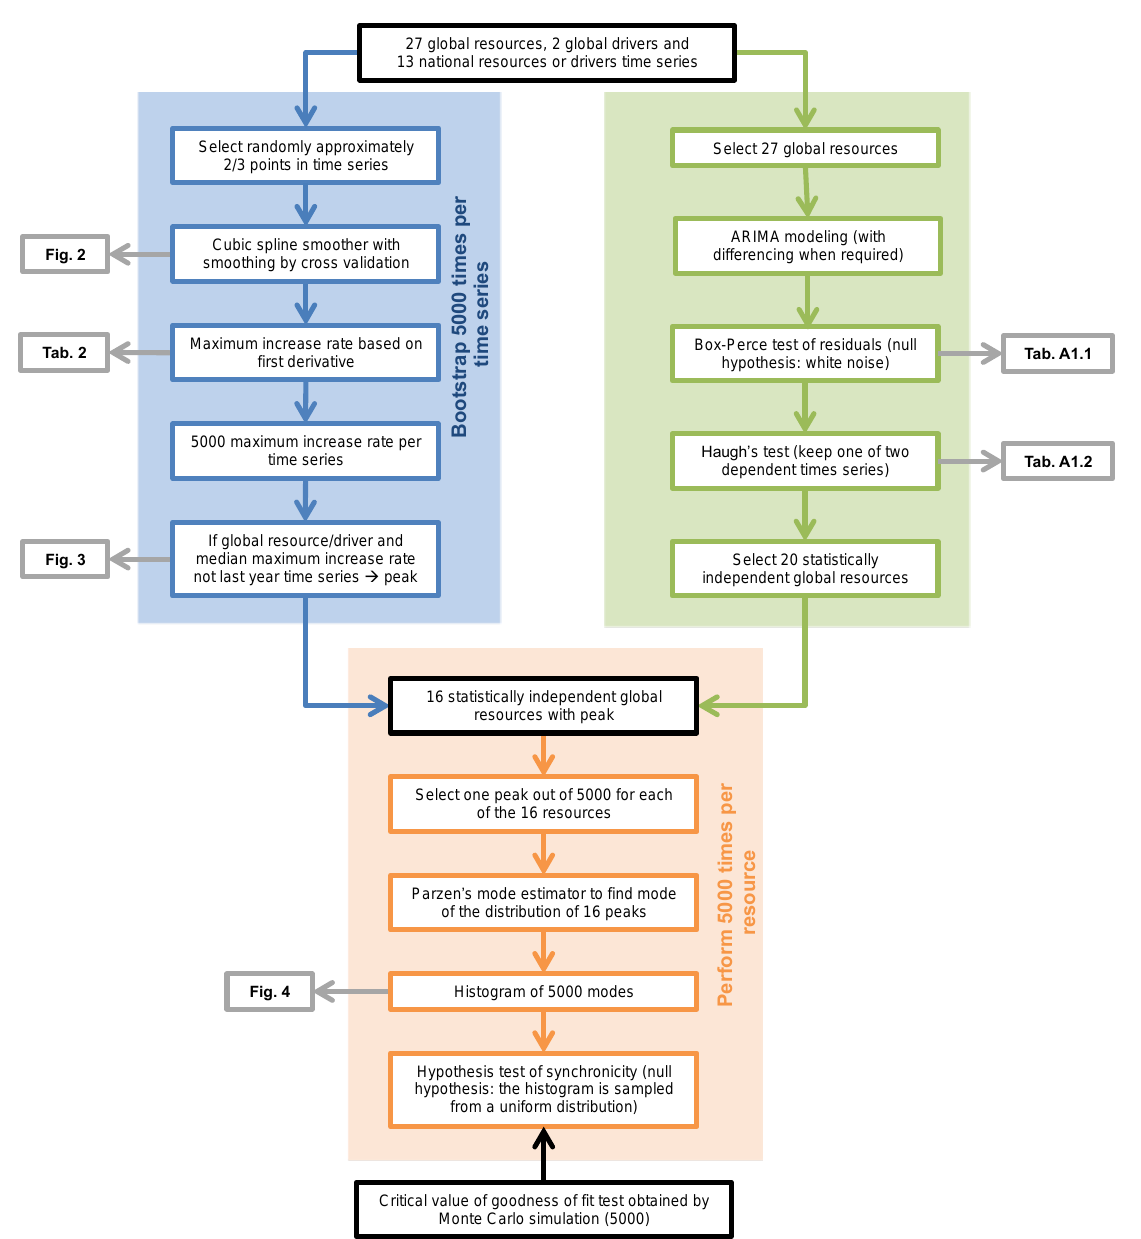
Figure A1.1 : Flowchart of data analysis. Blue: peak-rate year detection and estimate. Green: time series analysis and statistically independent resource selection. Orange: test of the synchrony hypothesis. Gray: Output included in the paper.